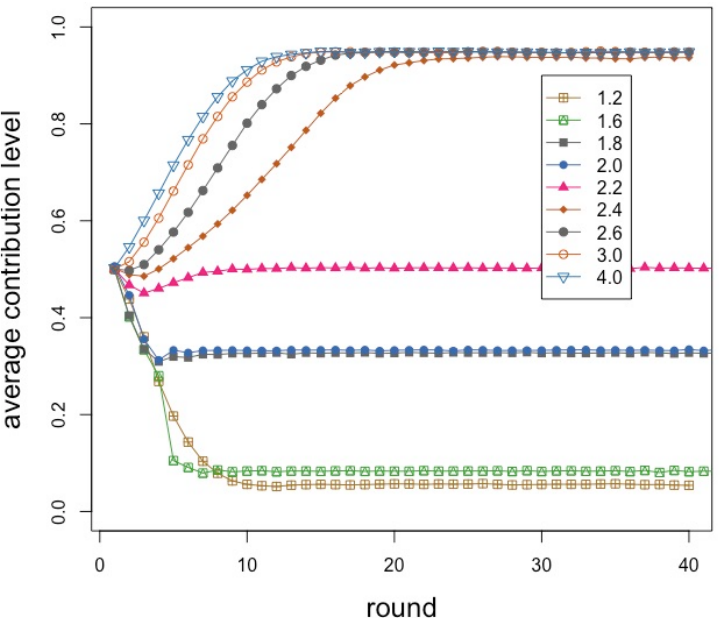
Figure 9. Average contribution as a function of round number for several values of the enhancement factor r as shown in the inset for the mixed model. The average is over 40 independent repetitions of 40 rounds each on a network of size